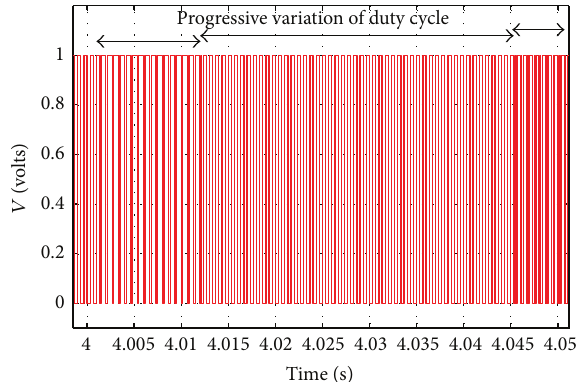
Figure 8: Duty cycle variation with varying step sizes.